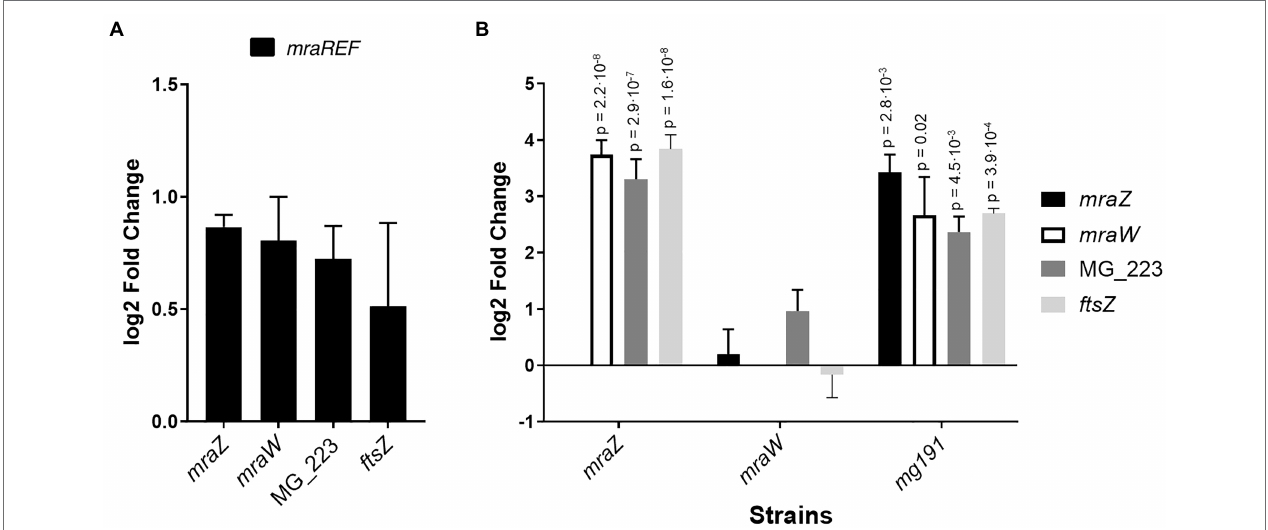
FIGURE 4 | Transcriptional analysis of the cell division gene cluster of several M. genitalium mutants by qRT-PCR. Transcriptional changes of the cell division gene cluster in the mraREF mutant (A) or the mraZ , mraW , and mg191 mutants (B) compared to the wild-type strain. Bars represent the average log2 fold change of at least three independent biological repeats. Statistical significance was assessed using the Student’s t -test, and the value of p of biologically significant values (log2 ± 1) is stated above the corresponding bar if significant (value of p < 0.05).